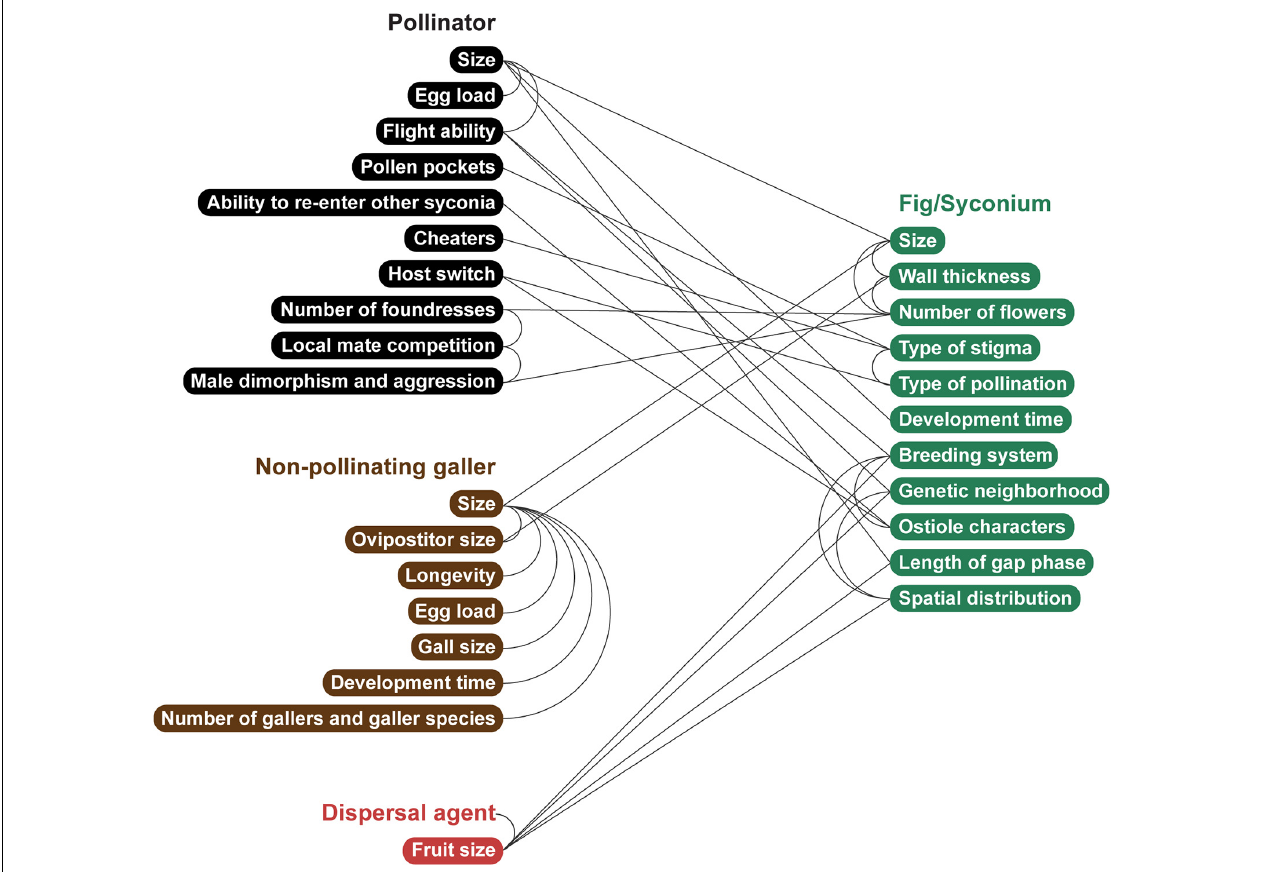
FIGURE 3 | The possible network of causal and/or correlative connections between traits of figs, pollinators, illegitimate gallers, and fruit dispersal agents. This network does not exhaustively show all possible connections but illustrates a holistic integrative view of how multi-partner interactive traits and selection pressures may be viewed. Illustration by Priya